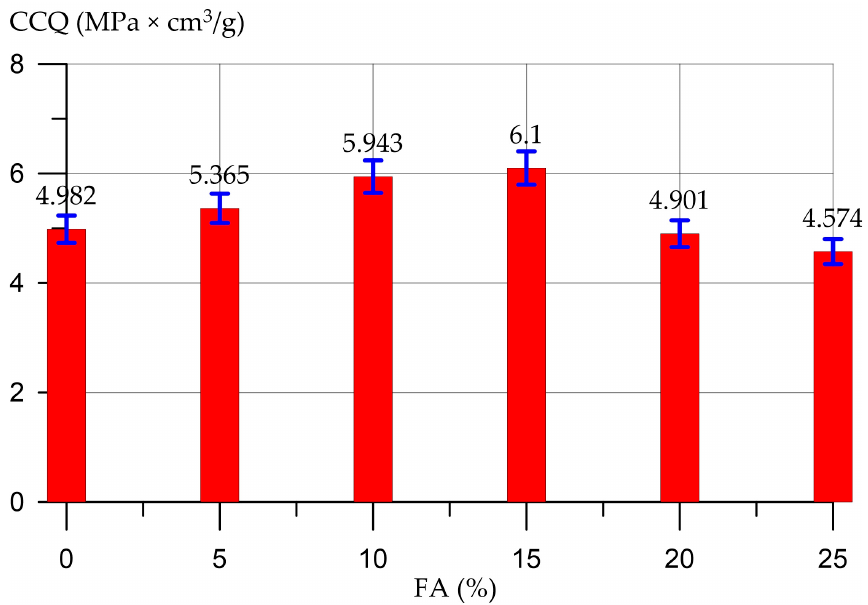
Figure 8. CCQ values of non-autoclaved aerated concrete modified with different FA content.